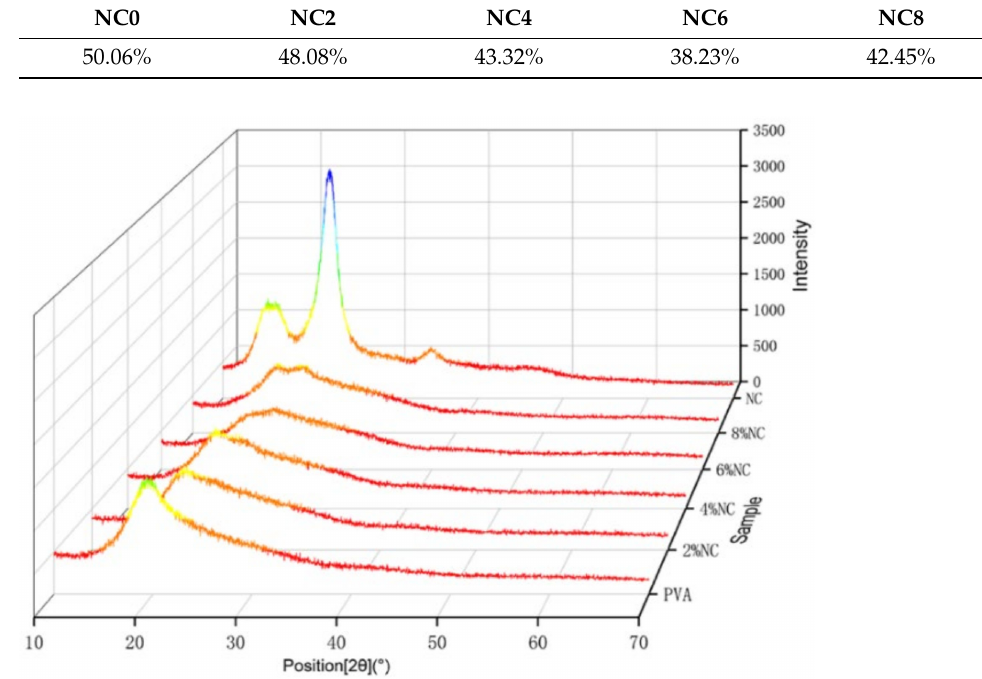
Figure 5. XRD patterns of PVA/NC nanofiber membranes with different NC content and pure